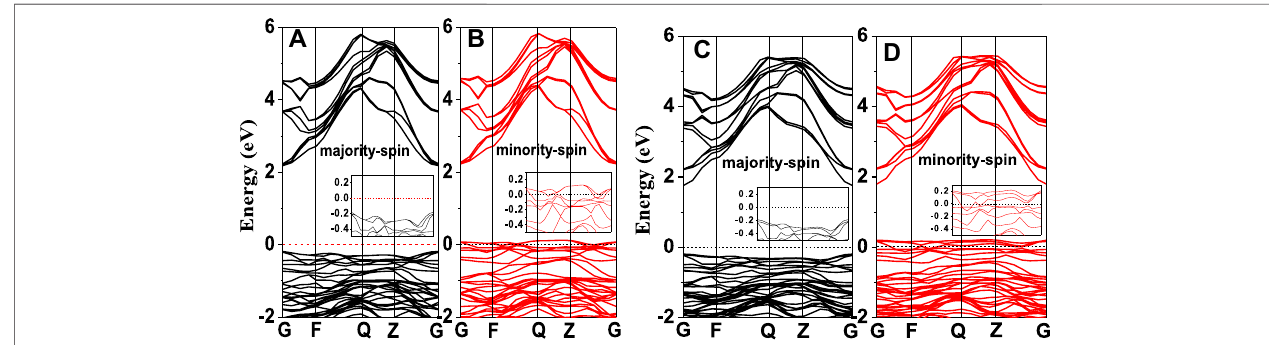
FIGURE 3 | The spin polarized band structures of Li(Mg 0.875 Cu 0.125 )N (A,B) ; and Li 0.9375 (Mg 0.875 Cu 0.125 )N (C,D) . Inset: Enlarged views near Fermi level.